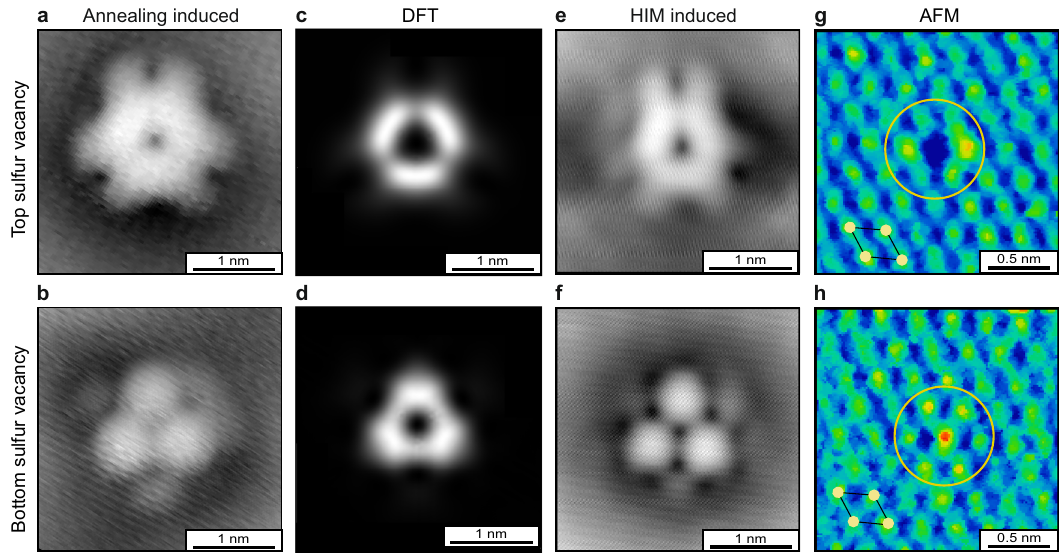
Fig. 3 Scanning probe microscopy of sulfur vacancies in single-layer MoS 2 on graphene. a , b Scanning tunneling microscope (STM) images of annealing induced vacancies in the top and bottom sulfur layer. The STM imaging parameters were tip bias V bias = 450 mV, tunneling current I t = 100 pA. c , d Density functional theory (DFT) calculations of 7 × 7 supercell containing one sulfur vacancy. The image displays a constant height slice 4.5 Å above and below the MoS 2 layer corresponding to the charge density from sulfur vacancies in the top and bottom sulfur layer, respectively. e , f STM images of He-ion (HIM) induced top and bottom sulfur vacancies. g , h Atomic force microscopy (AFM) images of the top and bottom sulfur vacancies. The centers of the circles highlight the position of the vacancy defect. The pictogram indicates the sulfur lattice (yellow